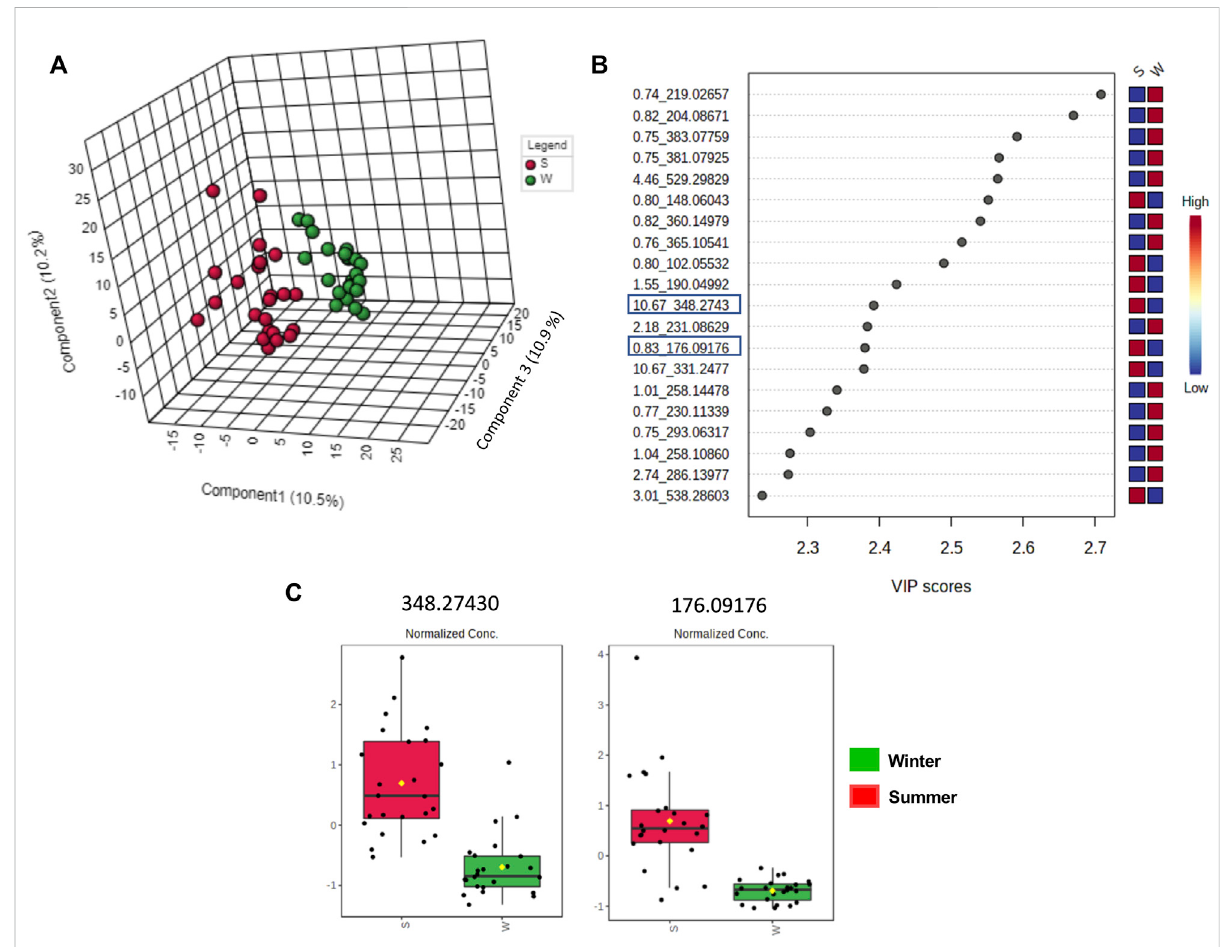
FIGURE 11 MultivariateanalysisfromLC-HRMSdataof V.album mothertincturesinpositiveESImode.Discriminationofthesamplesinrelationto V.album season harvesting. (A) PLS-DA 3D score plot. (B) VIP end point (C) Box plot graphs of the annotated metabolites (VIP) responsible for discriminating winter (green) and summer (red) samples. Blue rectangles: annotated VIP.